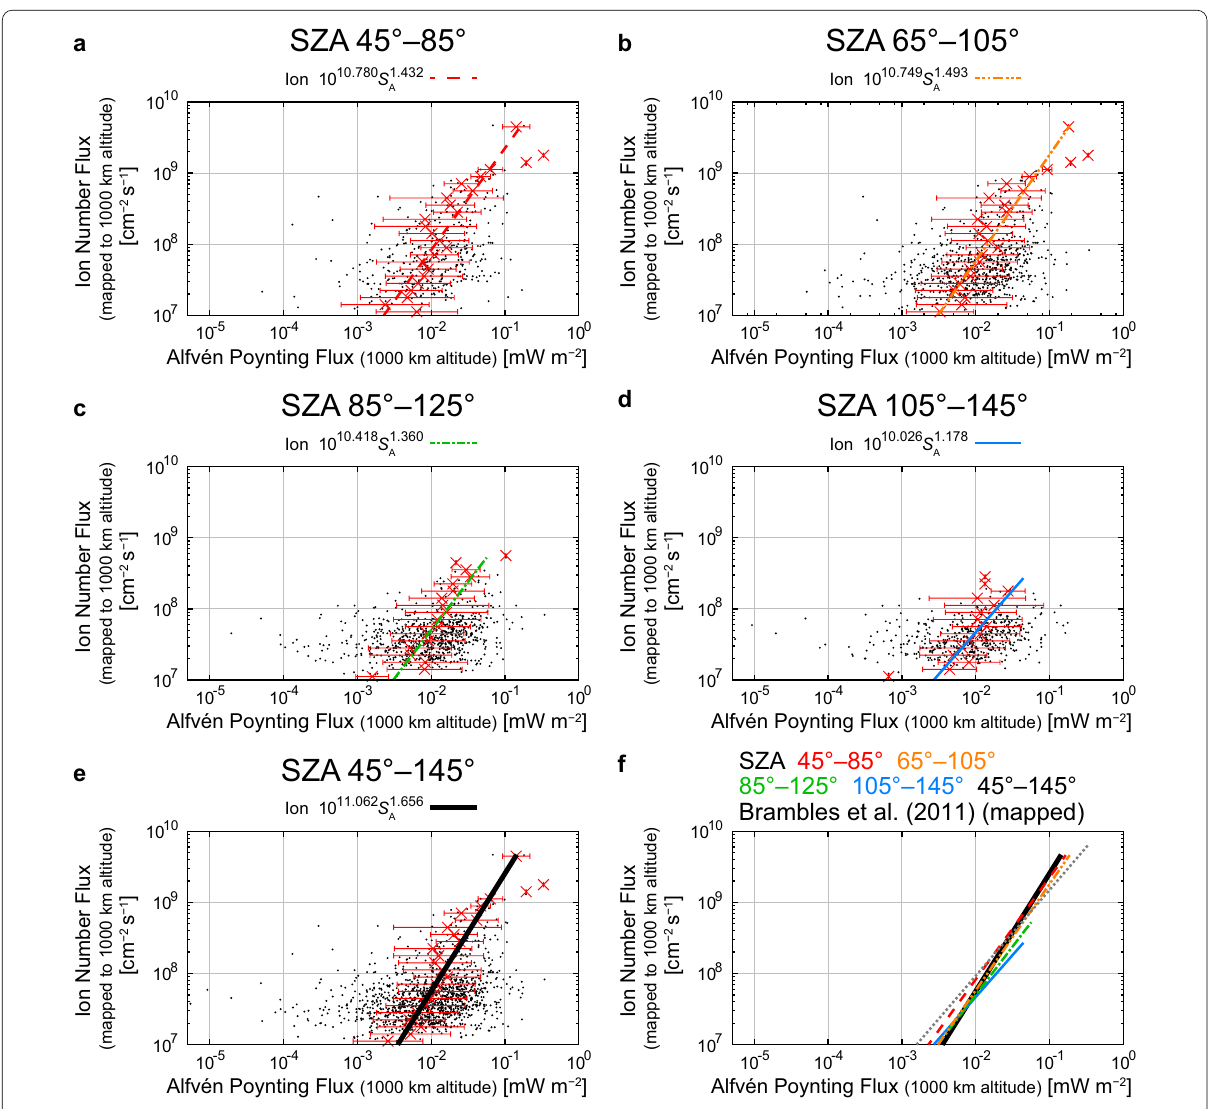
Fig. 6 Relations between the mapped Alfvén Poynting flux (0.125–0.5 Hz) and the mapped outflowing ion number flux in the SZA ranges of a 45°–85°, b 65°–105°, c 85°–125°, d 105°–145°, and e 45°–145° (all events), and f comparisons among the derived empirical relations in the SZA ranges and the empirical formula derived by Brambles et al. (2011) (multiplied by a factor of 2.9 here to correct for the altitudinal difference of the ion number flux and the Alfvén Poynting flux) (dotted gray line). The format is identical to that of Fig.